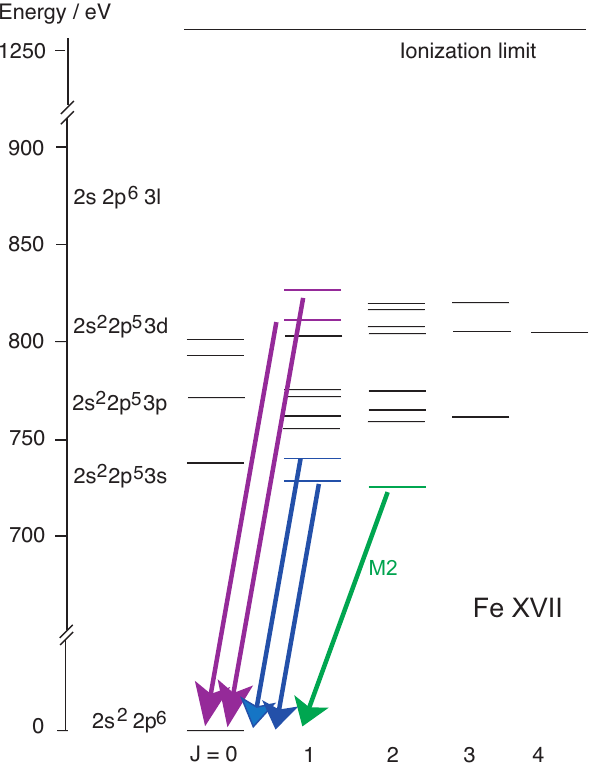
Figure 2. Schematics of the 26 lowest (2s 2 2p 6 and 2s2p 6 3l) levels in the Ne-like spectrum of the ion Fe 16 + (spectrum FeXVII). The transitions marked by arrows are (blue) the resonance and intercom- bination lines, (purple) the so-called 3C and 3D transitions, and (green) the prominent magnetic quadrupole transition. These are among the transitions discussed in the